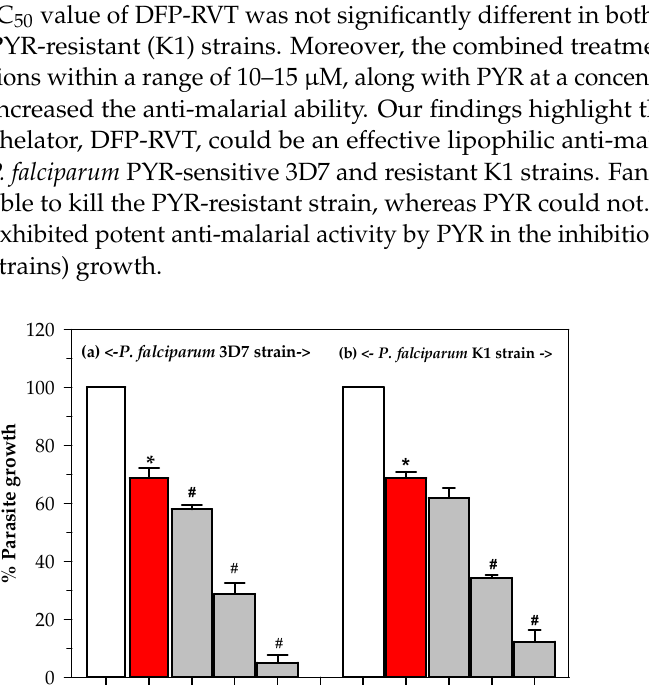
Figure 6. Intracellular LIP levels in P. falciparum (3D3 strain)-infected RBCs treated with DFP and DFP-RVT (0–200 µM each). Change in mean fluorescence intensity (  MFI) ( a ) and percentage changes of the MFI ( b ) values obtained from three independent experiments are presented as mean ± standard error of the mean (SEM) values. Statistical significance was determined using multiple t-tests, for which a p -value of < 0.05 was considered significant. # p < 0.05 when compared with consecutive lower concentrations; * p < 0.05 when compared with DFP at equal concentrations. 3. Discussion Iron is essential for the growth, development and overall health of the metabolisms of fast-dividing plasmodium parasites. Iron levels are also associated with anti-malarial drug resistance in endemic areas. Consequently, iron chelators would be an alternative or adjunctive anti-malarial agent in respective mono- or combined-therapy to eliminate se-